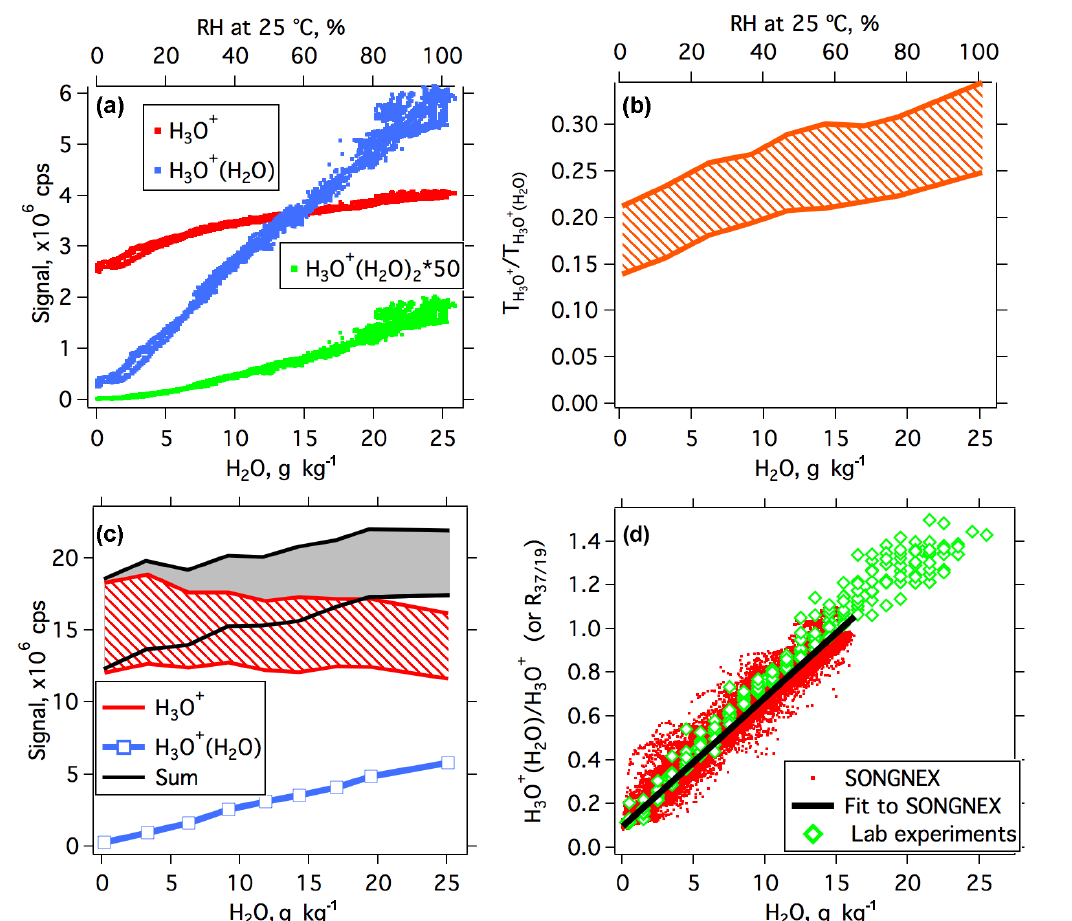
Figure 3. (a) Reagent ion signals as a function of water vapor mixing ratios in the instrument. (b) Inferred transmission ratios between ) as a function of water vapor mixing ratios. (c) The H 3 O + signals and total signals of the H 3 O + and H 3 O + (H 2 O) ions ( T H + /T H + ( H 3 O 3 O 2 O ) two reagent ions that are corrected to the transmission factor of H 3 O + (H 2 O) ions as a function of water vapor mixing ratios. The measured H 3 O + (H 2 O) signals are also shown. The shaded areas in (b) and (c) indicate the possible ranges of the parameters, which are bounded by estimates from the depletion experiments of methanol and acetonitrile, respectively. (d) H 3 O + (H 2 O) / H 3 O + ( R 37 / 19 ) as a function of water vapor mixing ratios during SONGNEX and from laboratory experiments. The black line is the linear fit to all of the SONGNEX